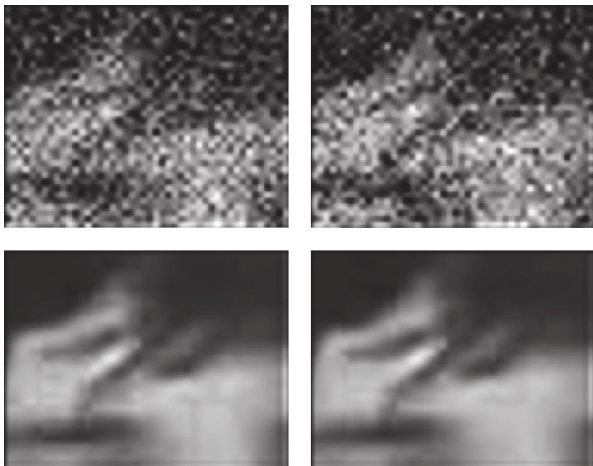
Figure 5: Zoom of noisy Miss America sequence ( 𝜎 𝑛 = 40 ). From left to right and from top to bottom: result of [18] algorithm, result of [19] algorithm, result of [13] algorithm, and result of the proposed algorithm.